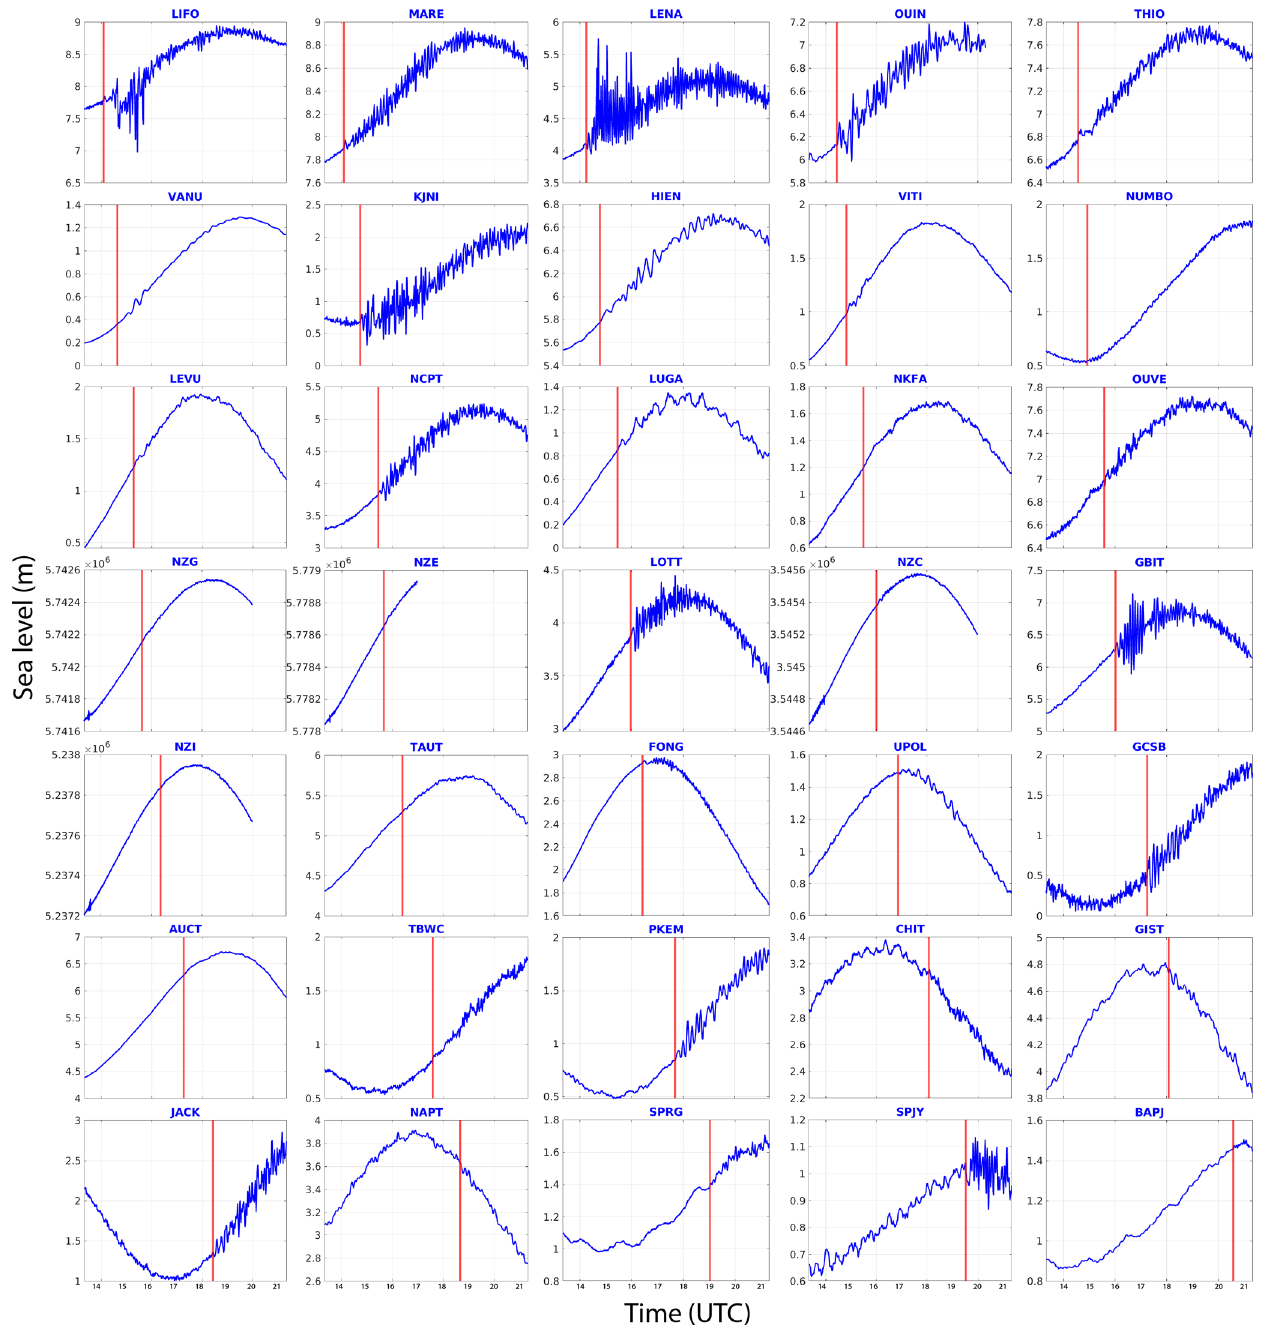
Figure 4. Thirty-five coastal gauge and New Zealand DART station records of the 10 February 2021 tsunami in the south-west Pacific Ocean. Each record begins at the time of the earthquake and goes on for 9h. The vertical red line represents the tsunami arrival time (reported in Table 2). For the four DART records, only the high-resolution signal (15s sampling rate) transmitted in real time by the bottom pressure recorder (BPR) to the monitoring centre is